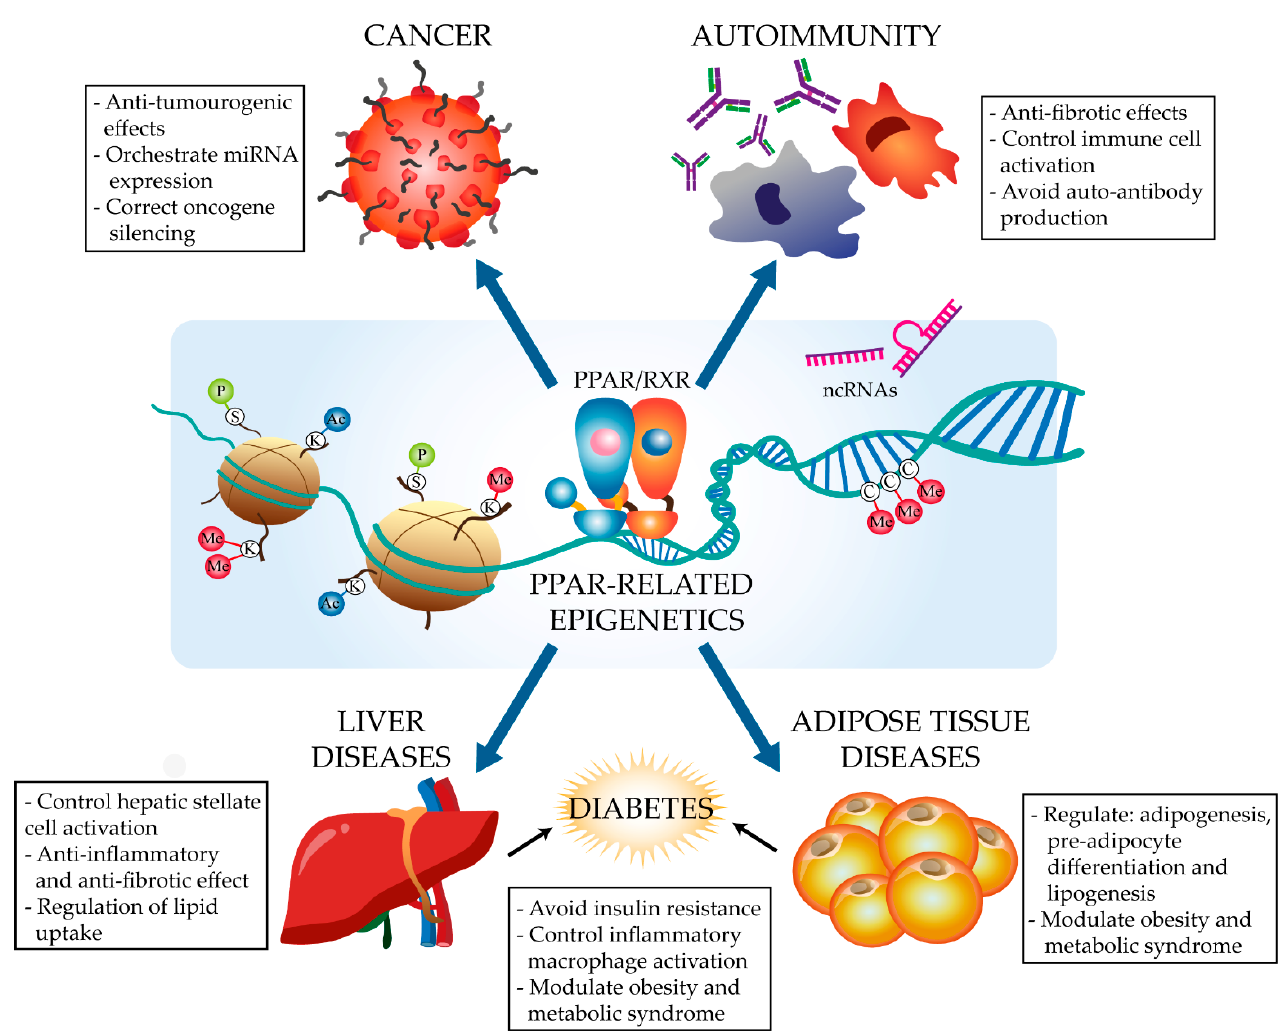
Figure 1. Scheme: PPAR epigenome implications in diseases. C, cytosine; Me, methyl group, ncRNAs, non-coding RNAs; K, histone lysine; S, histone serine; Ac, acetylation mark; P, phosphorylation mark.